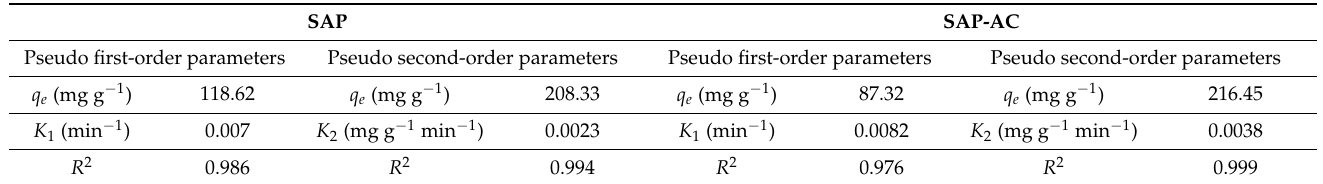
Table 3. Kinetic parameters for MB adsorption on SAP and SAP-AC as